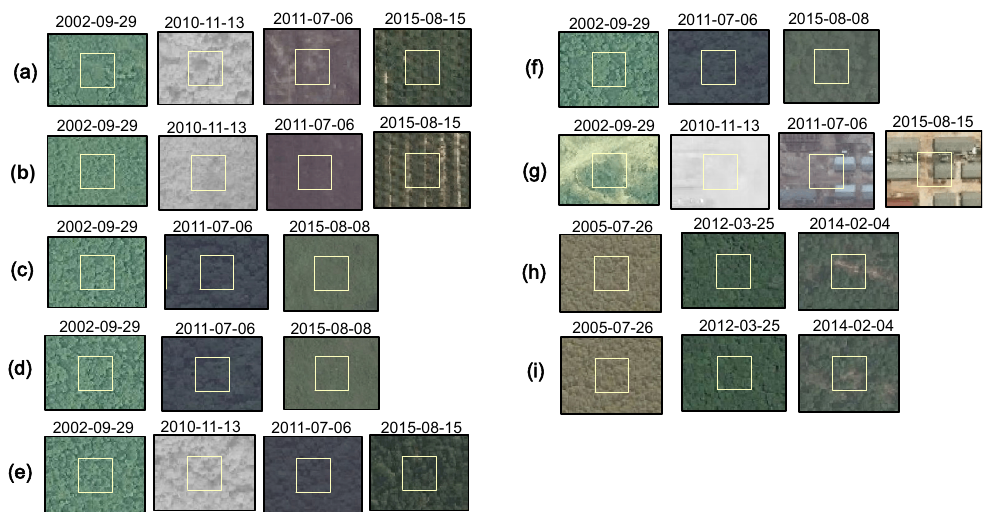
Figure 6. Very high spatial resolution (VHSR) image chip series corresponding to Landsat time series shown in Figure 5. The yellow squares are Landsat pixel area. The forest change cases are: forests cleared and converted into oil palm plantation ( a , b ); forests cleared and naturally revegetated ( c , d ); forests remaining forests i.e., non-deforestation ( e , f ); forests cleared and converted into settlements (e.g., built-up structure) ( g ); and small clearings in forests ( h , i ). The VHSR images were obtained through Digital Globe viewing